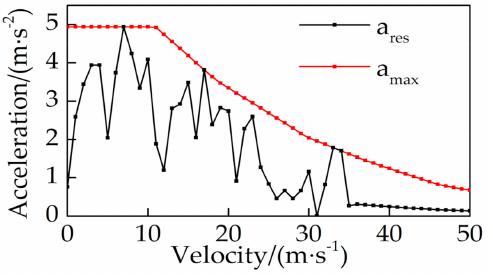
Figure 14. Acceleration reserves under the US06 cycle.